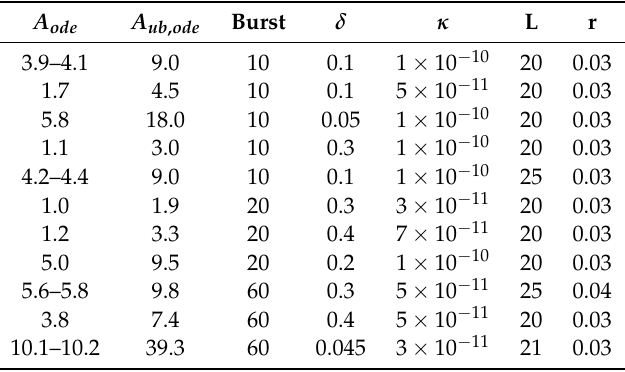
Table 5. A ode values for the ODE mass action